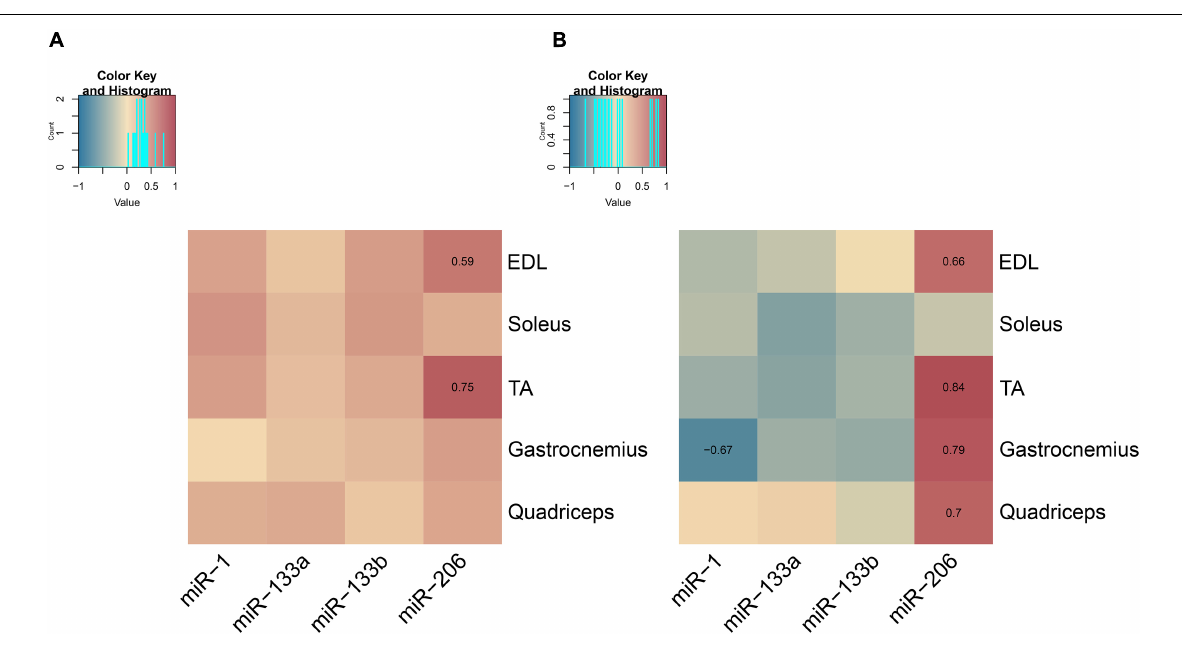
FIGURE 10 | Correlation maps associating endogenous and muscle-derived exosomal myomiR levels for the five skeletal muscles. Correlation analysis of the endogenous and muscle-derived exosomal myomiR levels was performed using the Spearman method. (A) Association of endogenous and muscle-derived fold change levels of the four myomiRs showed a trend toward a positive correlation between them. Endogenous and muscle-derived exosomal myomiR levels relative to their levels at 2 weeks followed a similar profile across age for all five skeletal muscles. Both endogenous and muscle-derived exosomal levels were found to increase with age for each skeletal muscle of interest. (B) Correlation of the normalized endogenous and muscle-derived exosomal miR-1, miR-133a, and miR-133b levels over the corresponding muscle weight was found to be slightly negative. miR-206 endogenous levels per muscle weight were found to be positively correlated with its muscle-derived exosomal levels for all the glycolytic muscles, EDL, TA, gastrocnemius, and quadriceps. For the oxidative muscle soleus, no correlation was observed between miR-206 endogenous and muscle-derived exosomal levels normalized to its weight. Correlation (rho) values are depicted in the squares and those close to +1 (red) denote a strong positive correlation, and values close to –1 (blue) a strong negative correlation. Correlation values with no significance do not show their value. p <